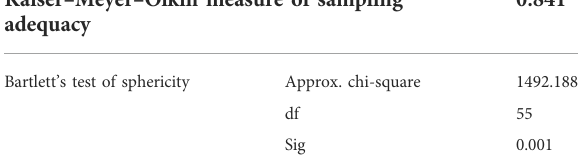
TABLE 4 KMO and Bartlett ’ s tests of sphericity for the key role identi fi